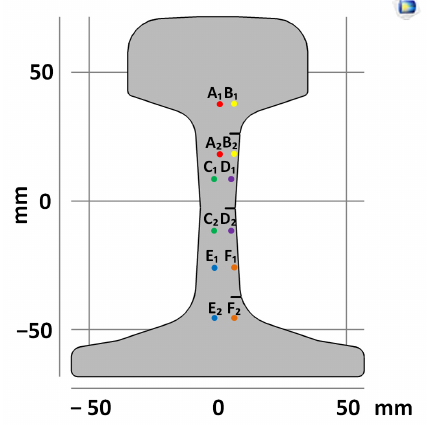
Figure 6. Model of the sample with points for comparative analysis of DIC and FEM .